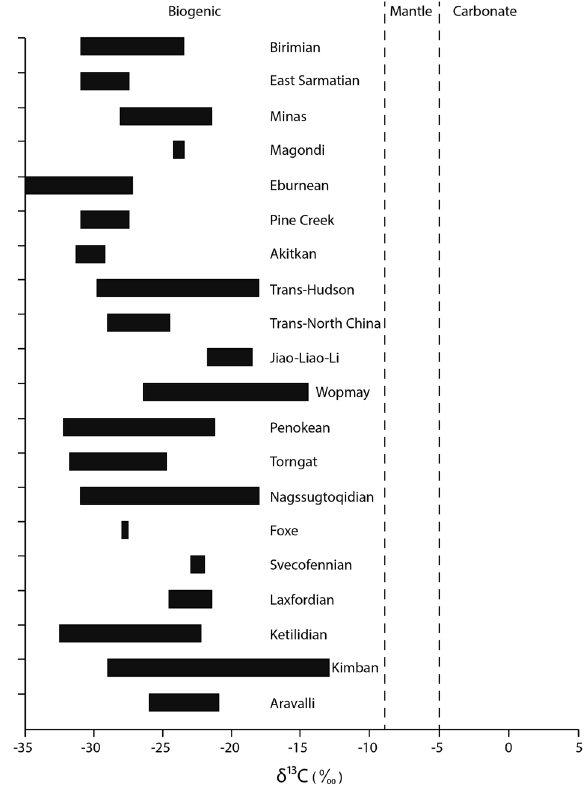
Fig. 5 Isotopic composition of carbon ( δ 13 C ‰ ) in carbonaceous rocks in twenty orogens. Orogens are shown in Fig. 1 and listed in Table 1. All data fall in range characteristic for biological carbon; none fall in range characteristic for magmatic carbon. Data sources in Supplementary Note